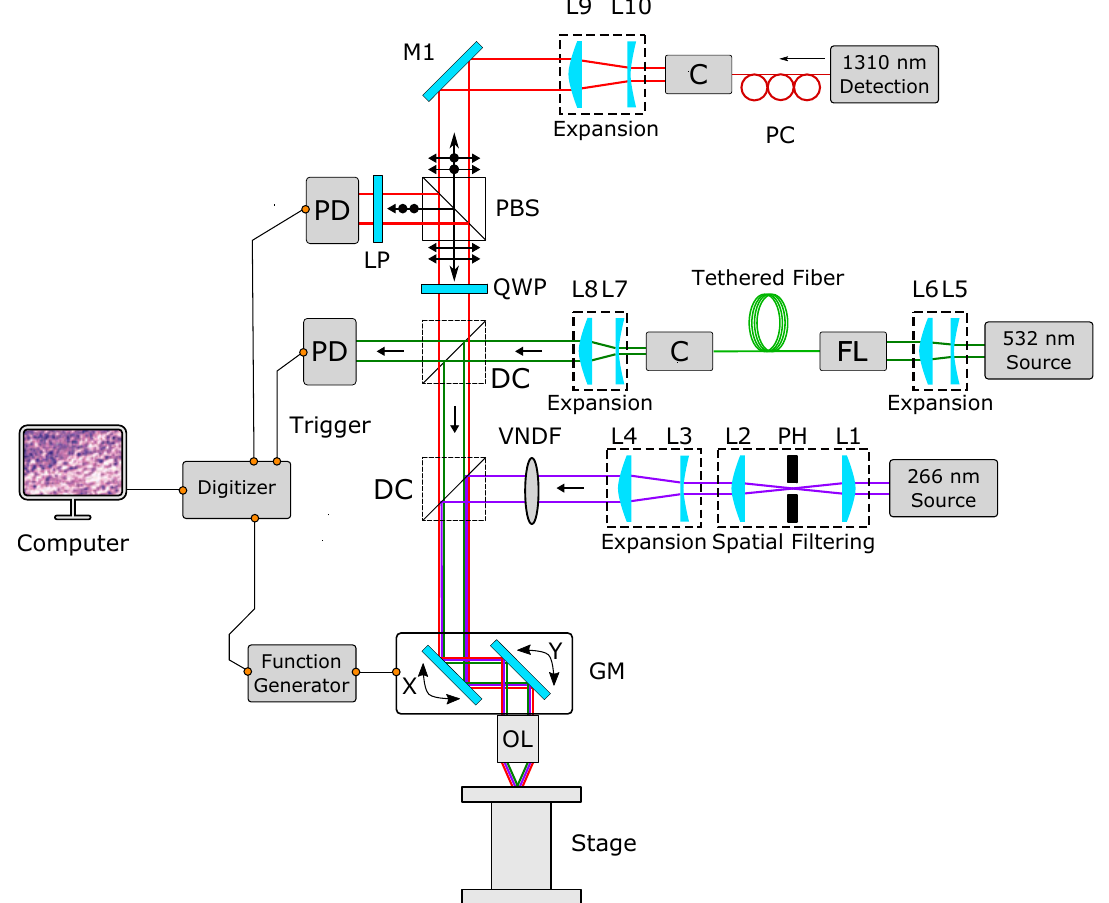
Figure 1. Schematic of the PARS microscope. Components labels are: pinhole (PH), variable neutral density filter (VNDF), collimator (C), polarized beam splitter (PBS), quarter waveplate (QWP), dichroic mirror (DC), photodiode (PD), fiber launch (FL), galvanometer mirrors (GM), lenses (L), mirrors